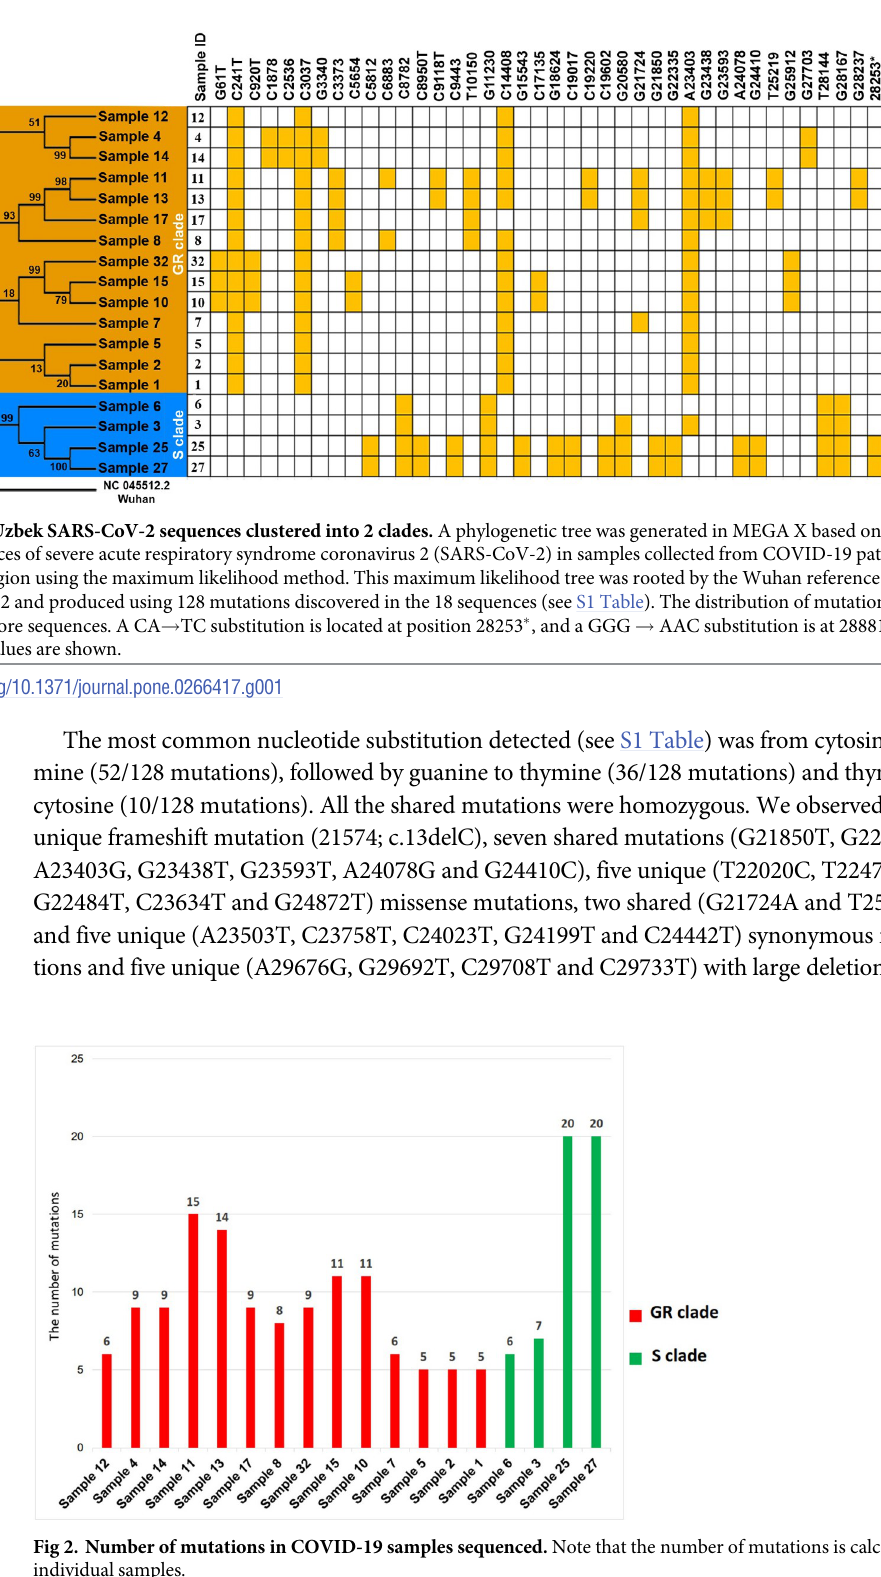
Fig 2. Number of mutations in COVID-19 samples sequenced. Note that the number of mutations is calculated per individual samples.